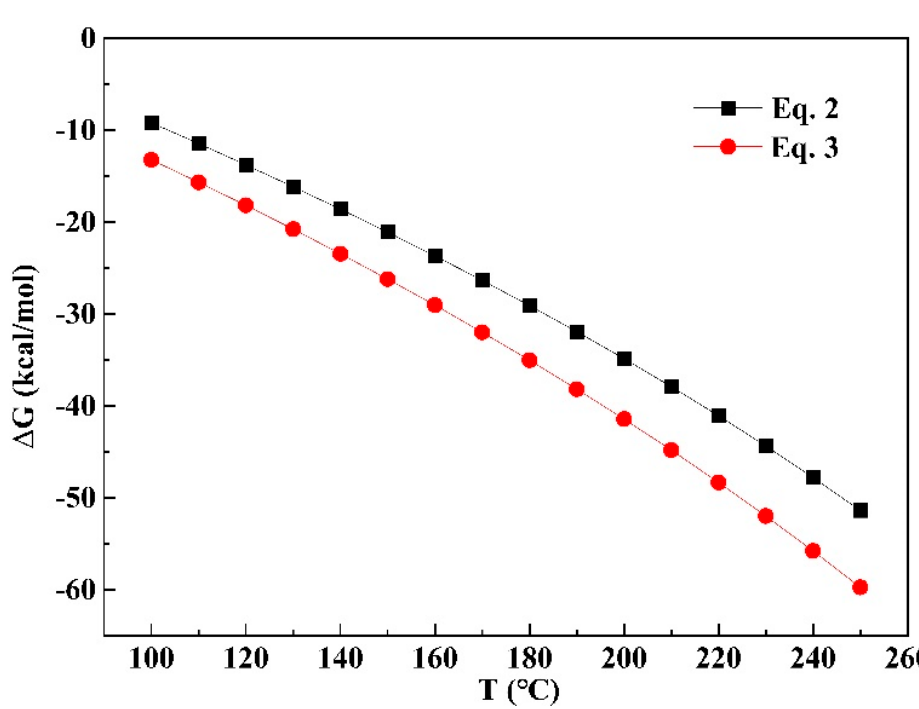
Figure 5. The Δ G θ values of Equations (2) and (3) at different temperatures.